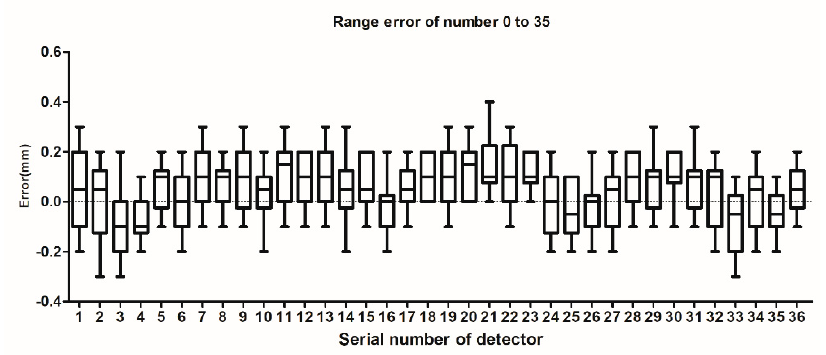
Figure 19. Box diagram of motion control error of 36-channel detector.